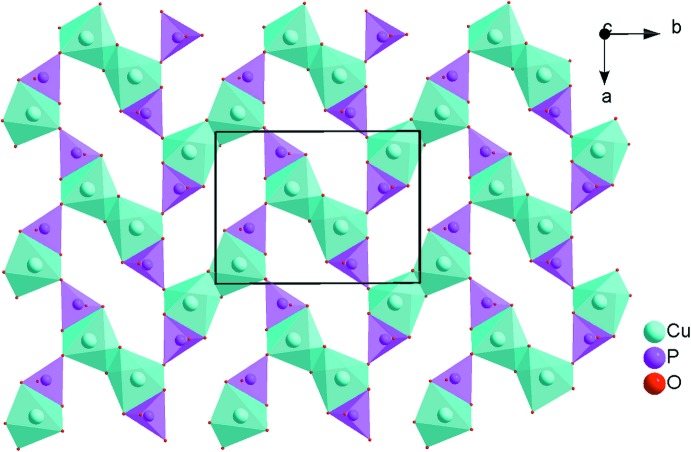
Projection along [001] of [Cu2P2O12] copper phosphate sheets in the crystal structure of NaCuIn(PO4)2.